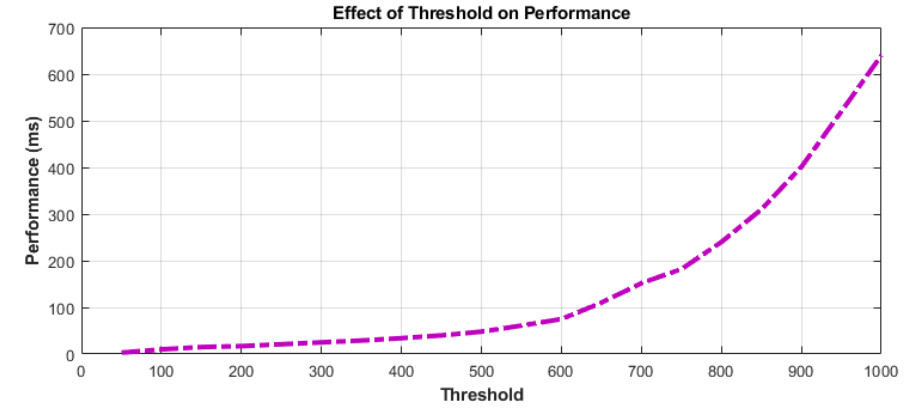
Figure 14. Overhead vs.